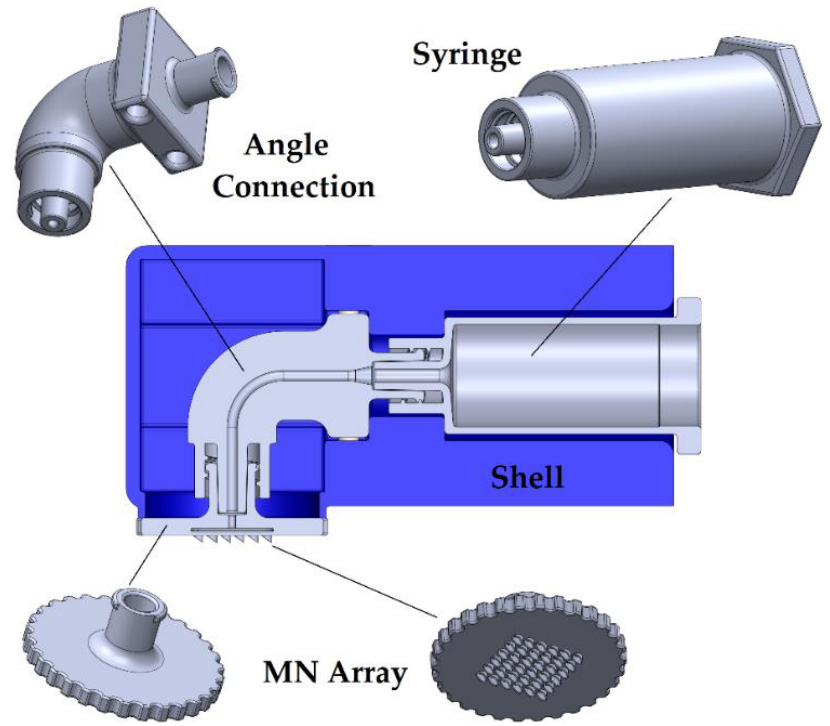
Figure 2. Sectional view of sub-assembly A.